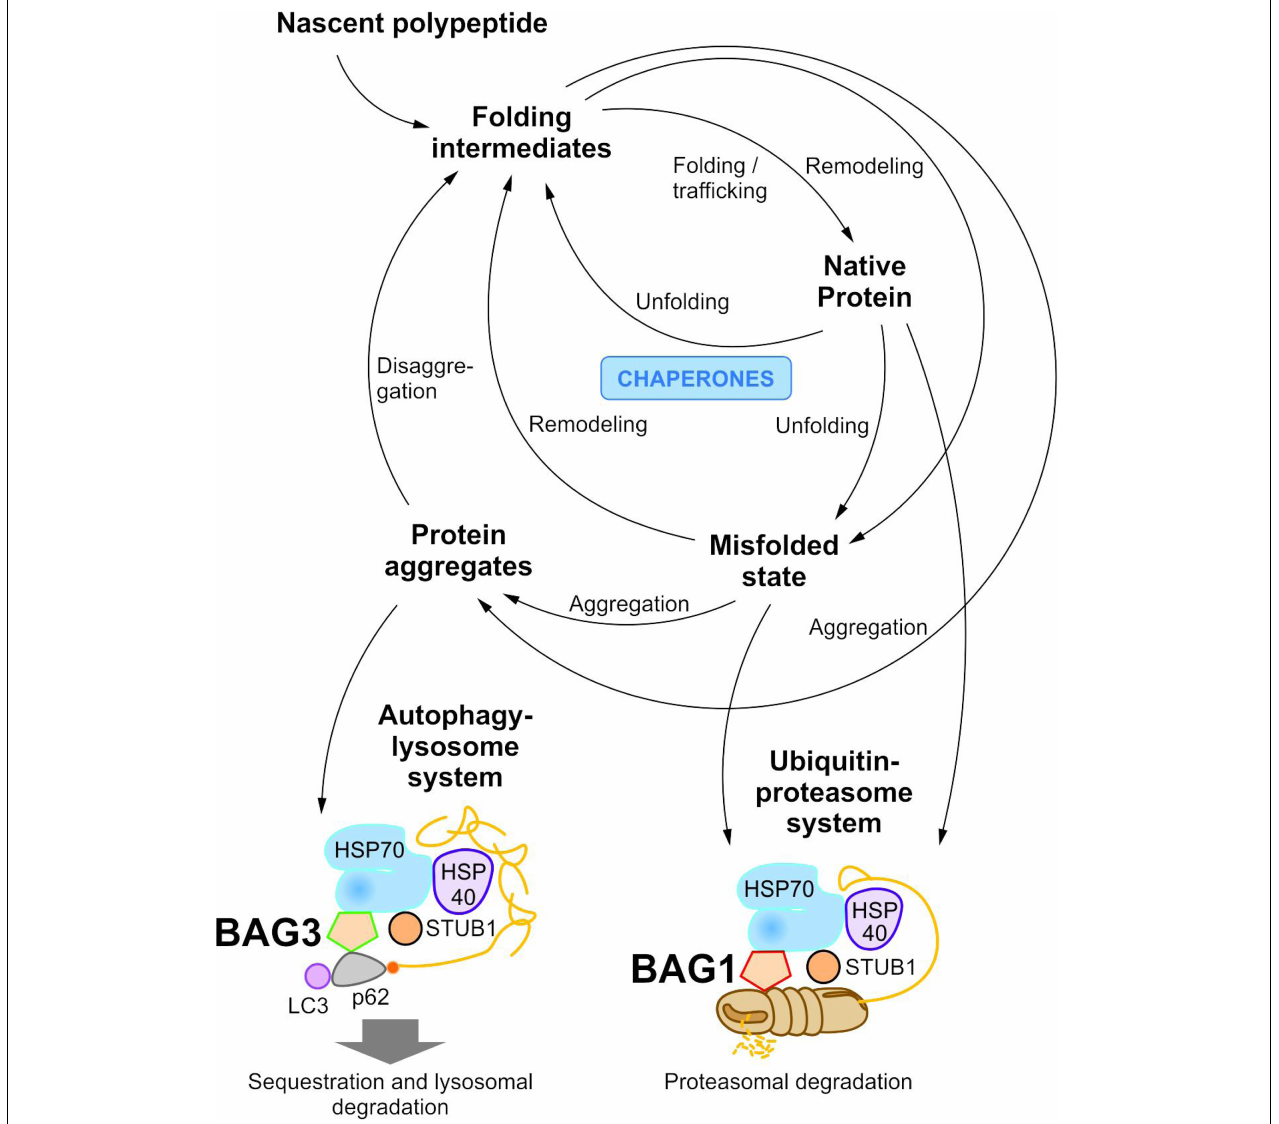
FIGURE 1 | The cellular proteostasis network and its degradation systems. In cellular protein quality control, molecular chaperone systems function in concert with protein transport and degradation systems to ensure cellular proteostasis. In addition to the ubiquitin-proteasome system, the autophagy-lysosome system mediates the disposal of degradation-prone